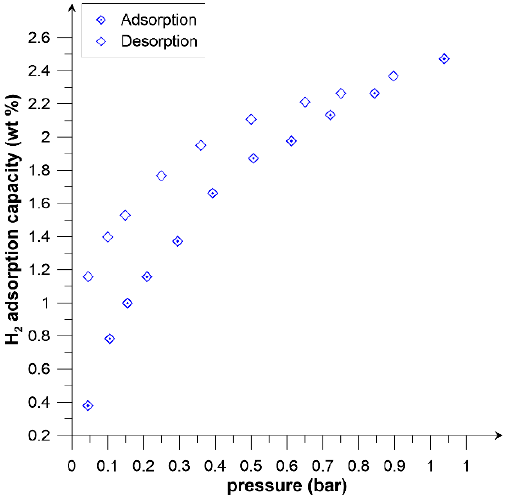
Figure 4. Adsorption/desorption isotherms of hydrogen onto Picazine at 77 K.